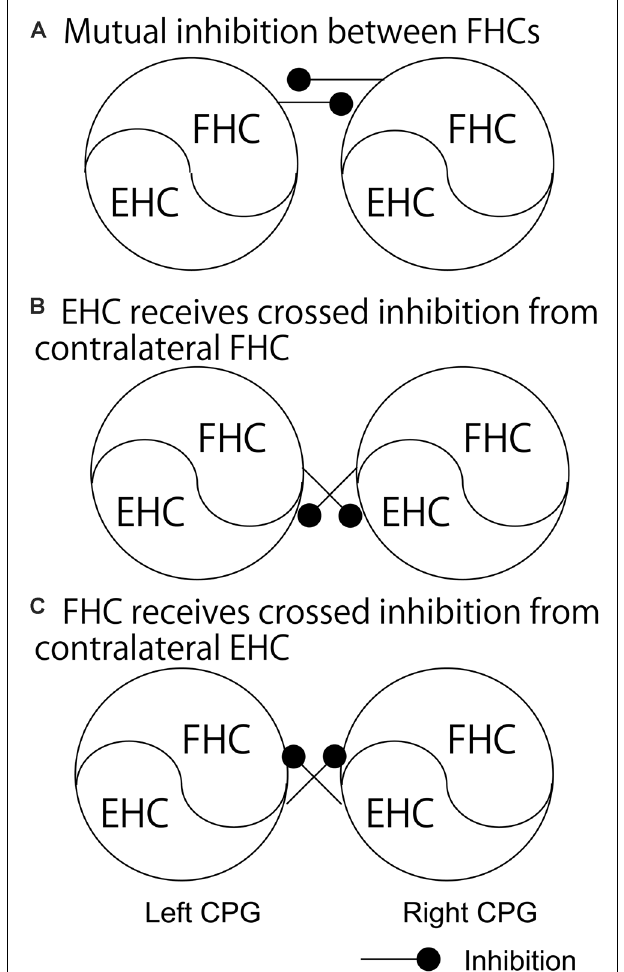
FIGURE 2 | The pathways regarding the phase-dependent crossed inhibition between the left and right half centers. A model proposed by Dietz (A) , a model indicated by the finding in the study by Frigon and colleagues (B) , and a model proposed by Ting and colleagues (C) are shown. Those pathways are discussed in the text. FHC, flexor half center; EHC, extensor half